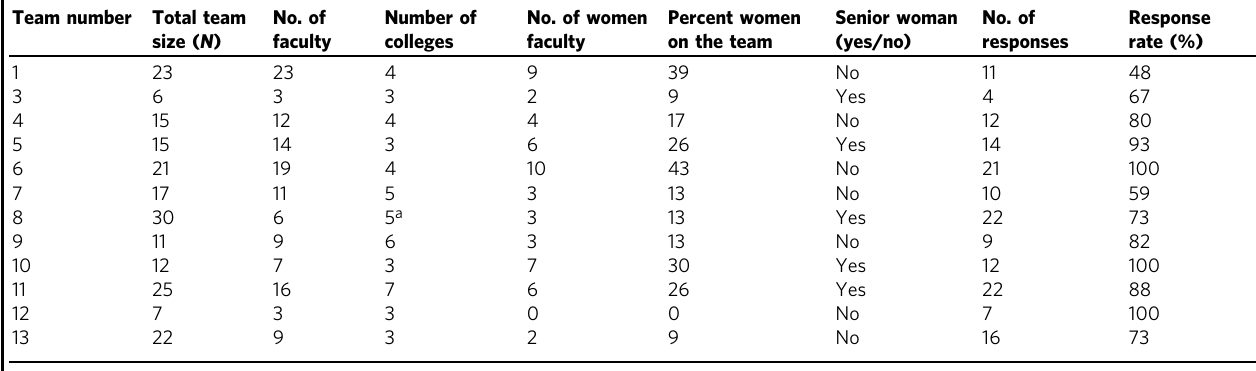
Table 1 Team demographic information and survey response rates. Team number Total team size ( N